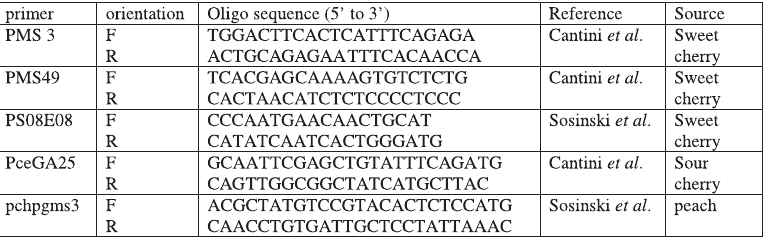
Table 2. SSR locus designation, the sequence of the oligos and the sources of the primers